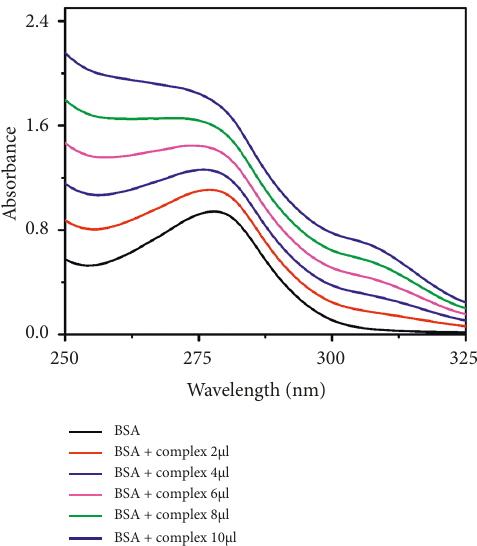
Figure 16: UV absorption titration of complex 2 (0–10 µ l) with BSA (1 µ M) in PBS buffer (pH